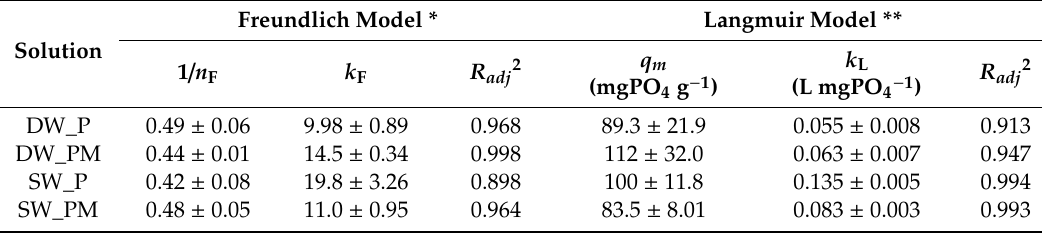
Table 3. Freundlich and Langmuir isotherm constants for phosphate adsorption onto alginate matrices cross-linked with Fe 3 + ions. DW_P—deionized water enriched with phosphate, SW_P—e ffl uent from a sludge enriched with phosphate, DW_PM—deionized water enriched with phosphate and metal ions, SW_PM—e ffl uent from a sludge enriched with phosphate and metal ions. Freundlich Model Solution